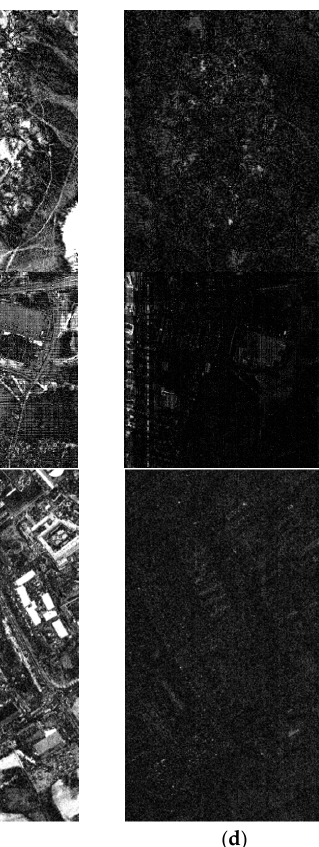
Figure 7. The 28th band residual images of different algorithms on different datasets near the 0.05 sampling rate, from top to bottom Cupriete, Urban, and PaviaU: ( a ) SSHCS, ( b ) SpeCA, ( c ) SSCR_SU, ( d ) DCHS.